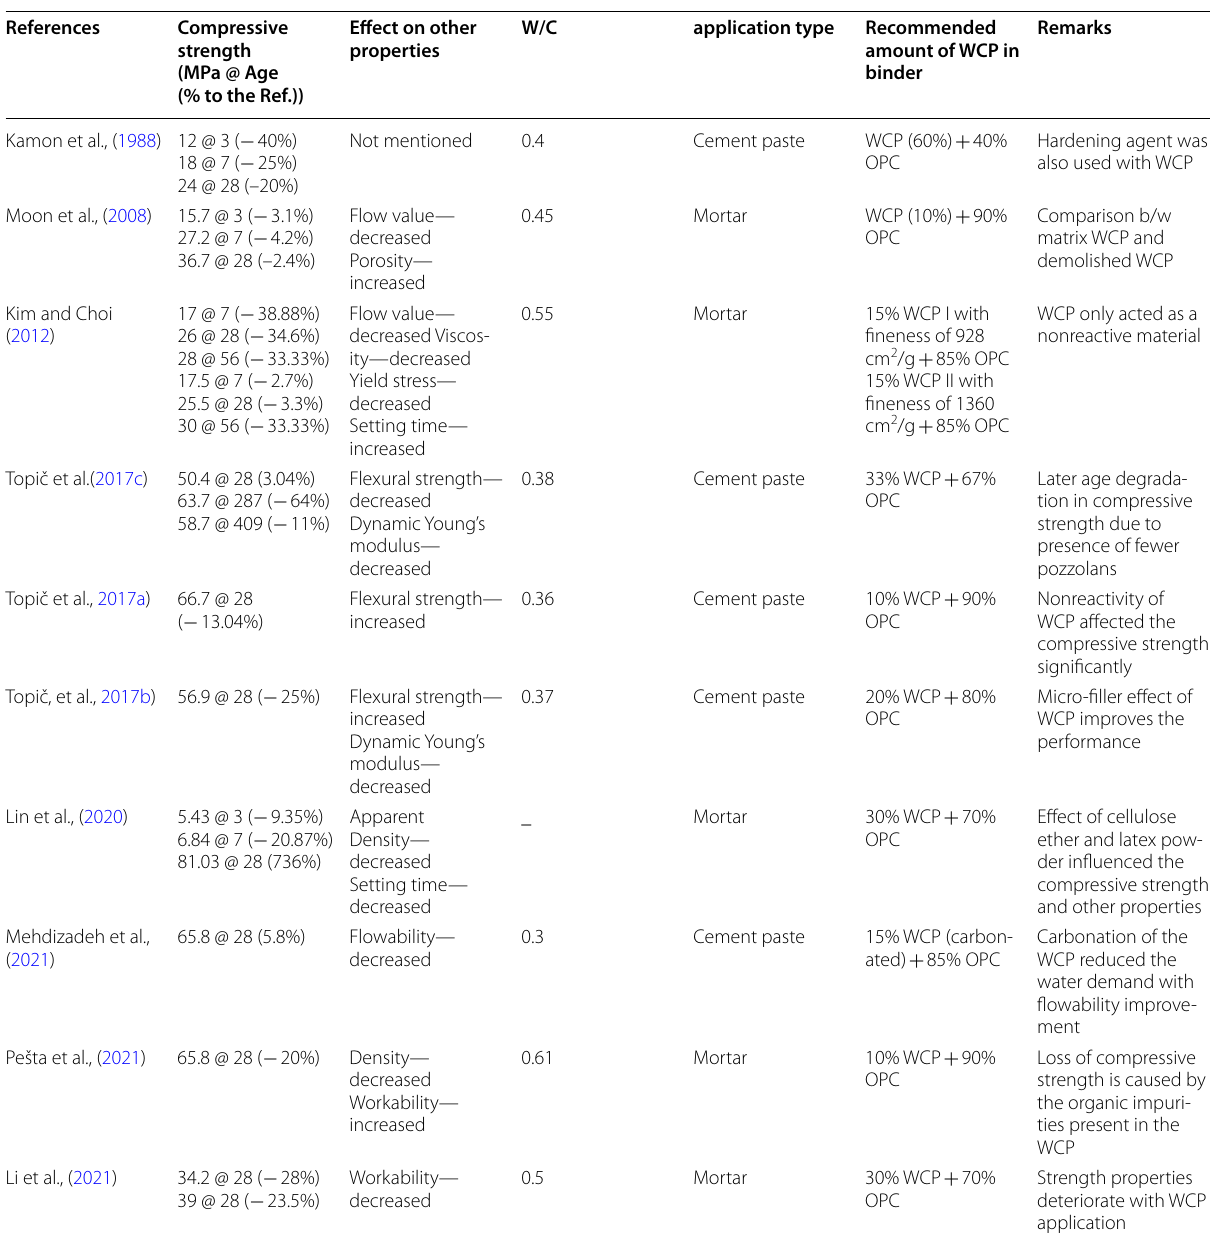
Table 1 Effect of WCP on compressive